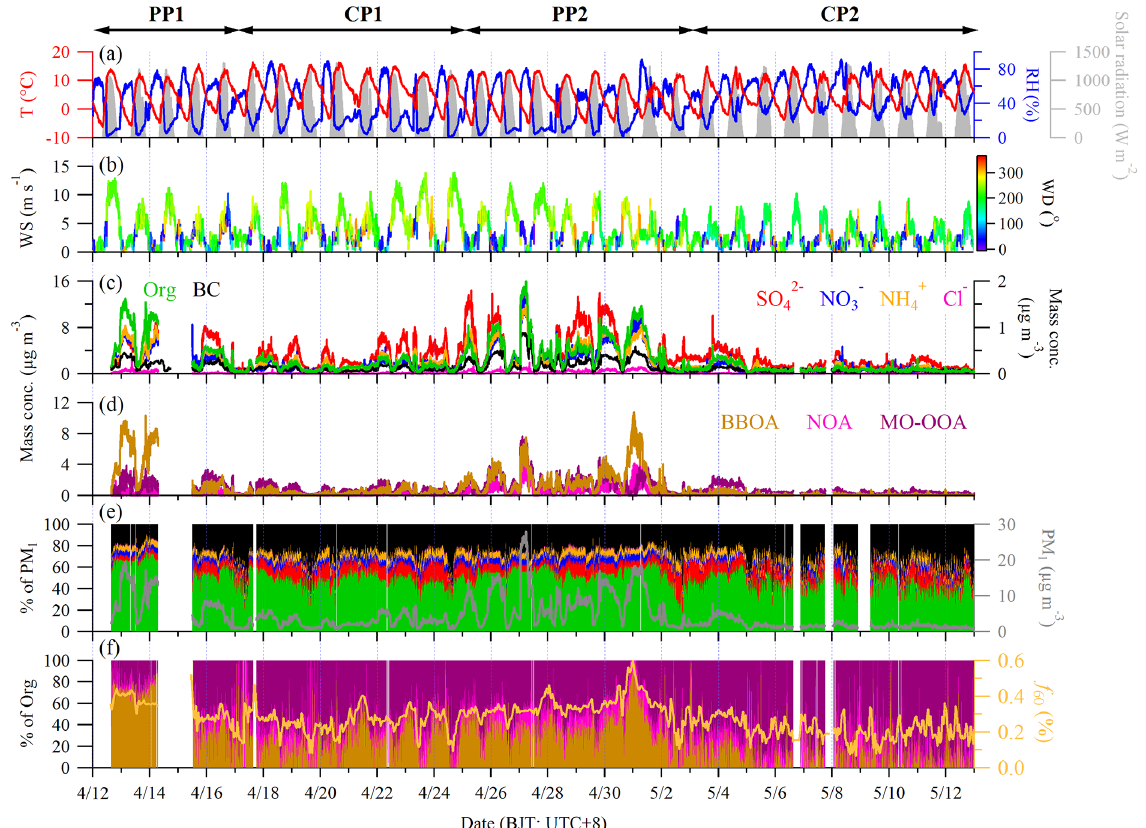
Figure 2. Summary of meteorological and HR-ToF-AMS data. The 5min time series of (a) ambient temperature ( T ), relative humidity (RH), and solar radiation, (b) wind speed (WS) colored by wind direction (WD), (c) mass concentrations of PM 1 species, (d) mass concentrations of organic components, (e) mass contributions of PM 1 species to total PM 1 as well as total PM 1 mass concentrations, and (f) mass contributions / OA) values for the entire period is also shown. The of organic components to organics. The time series of hourly average f 60 ( = C 2 H 4 O + 2 markers of PP1 and PP2 represent the two polluted periods while CP1 and CP2 are clear